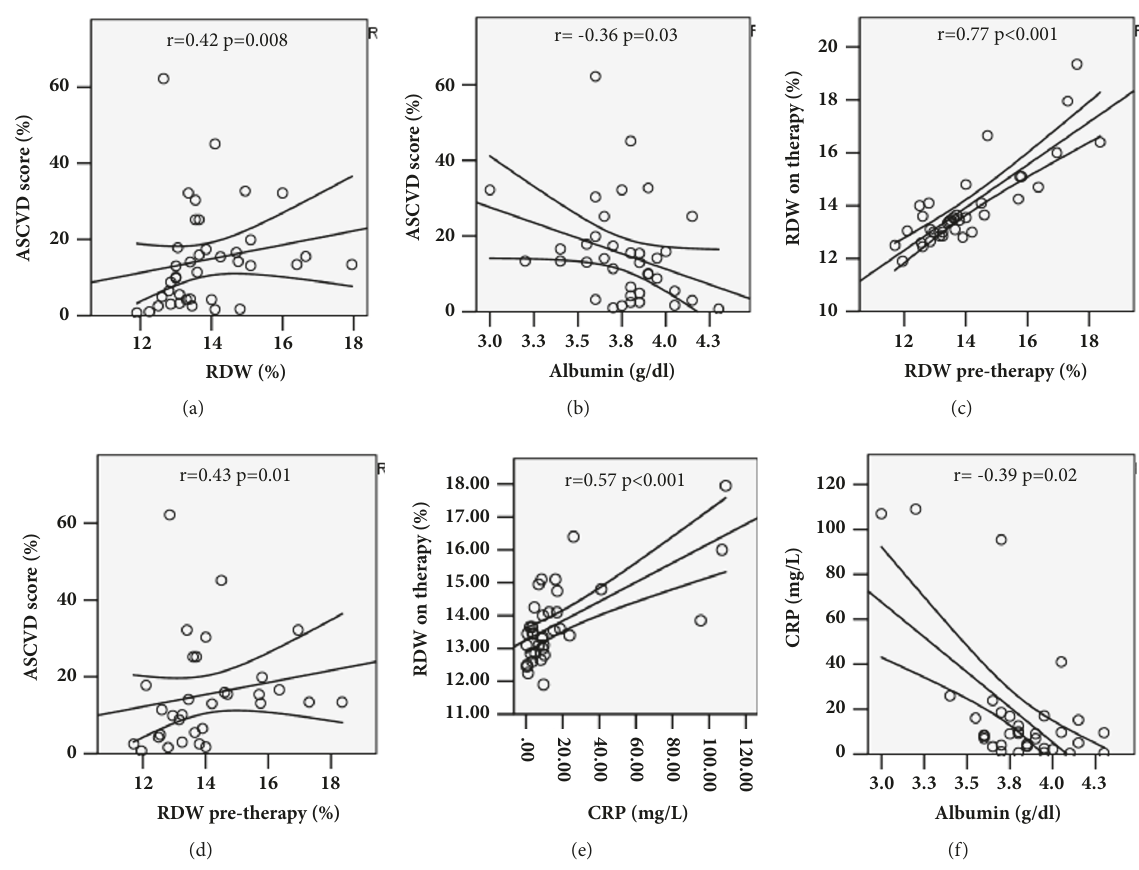
Figure 2: ASCVD 10-year risk score is correlated with RDW and albumin. (a) RDW versus ASCVD score %. (b) Albumin versus ASCVD score %. (c) RDW pretherapy versus on therapy. (d) RDW pretherapy versus ASCVD score %. (e) RDW versus CRP. (f) CRP and albumin. Spearman’s r and p values are shown, along with the linear trend line and 95% confidence